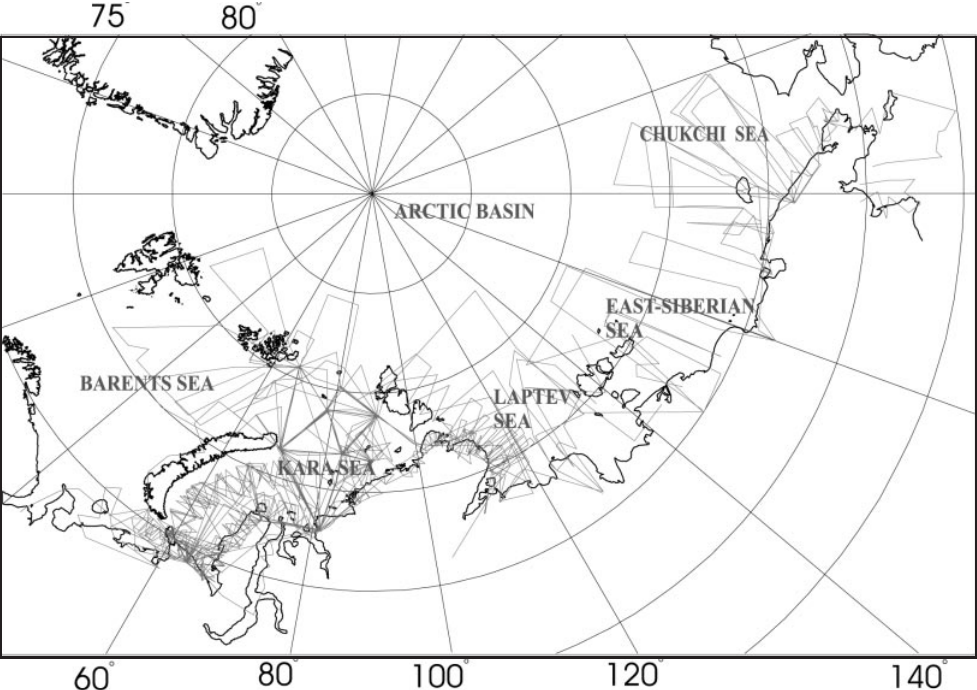
Fig. 2. Flight paths of ARSI in